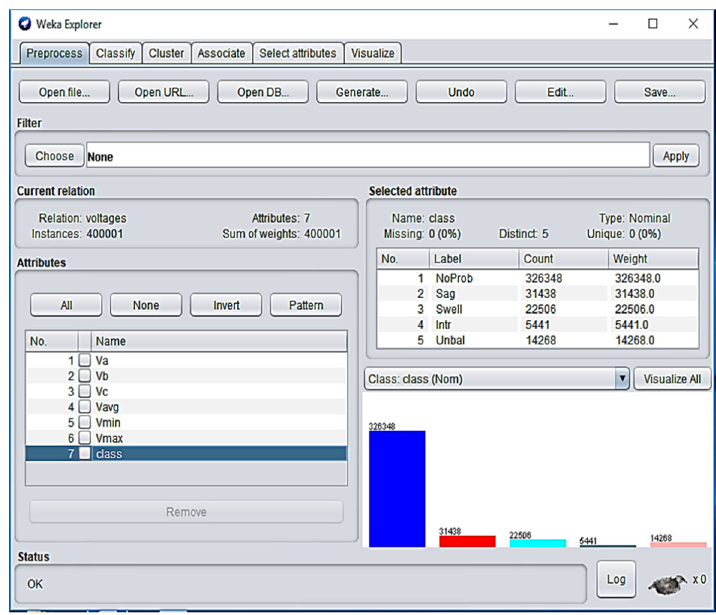
Fig. 10 Pre-process stage of data mining in WEKA with 7